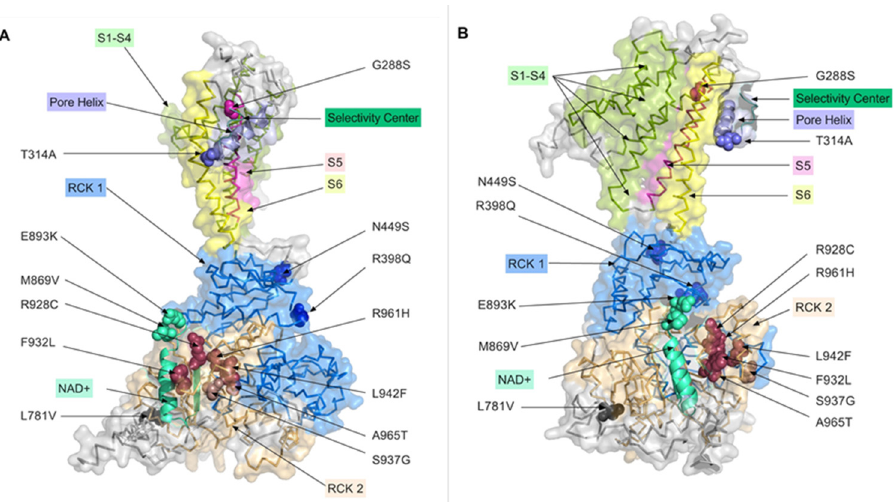
Figure 8. Distribution of the studied mutations on the 3D model of the KCNT1 channel. Mutations analysed in this paper were mapped onto the 3D structure of the chicken KCNT1 homolog, Slo2_2 in the open conformation deposited in the rcsb.org Protein Data Bank (PDB, http://doi.org/10.2210/pdb5U70/pdb, accessed on 3 November 2022) [20,21], with colours corresponding to the functional domains they are located in (see Section 4). The projection of a single KCNT1 subunit shown in panel ( B ) is obtained by anticlockwise rotation of the projection shown in panel ( A ) by 90 degrees around the vertical axis.